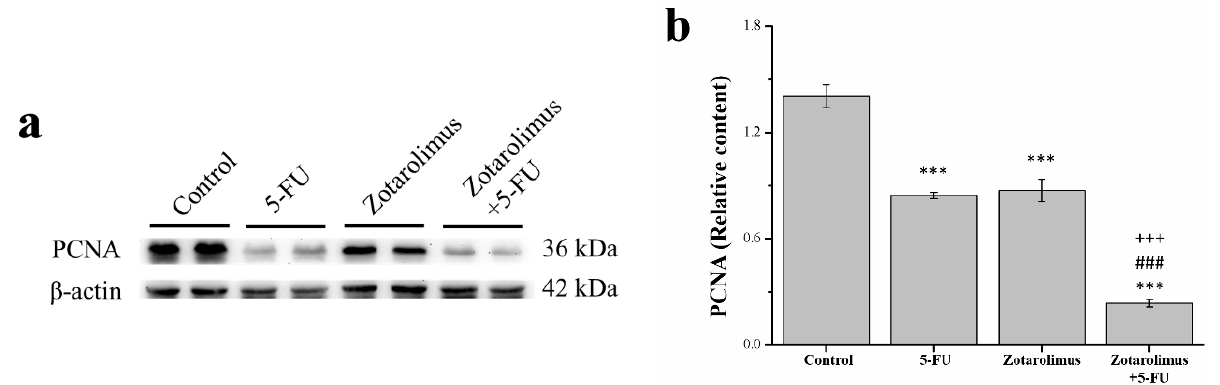
Figure A4. Western blot analysis of ( a ) PCNA and ( b ) the relative quantitative expression of PCNA in A549 tumors taken from BALB/cByJNarl mice provided with different treatments, including control, 5-FU (100 mg/kg/week), zotarolimus (2 mg/kg/day), and zotarolimus (2 mg/kg/day) combined with 5-FU (100 mg/kg/week). All data are presented as mean ± standard deviation, n = 7 per group. *** p < 0.001 compared with the control group. ### p < 0.001 compared with the 5-FU-treated group. +++ p < 0.001 compared with the zotarolimus-treated group.